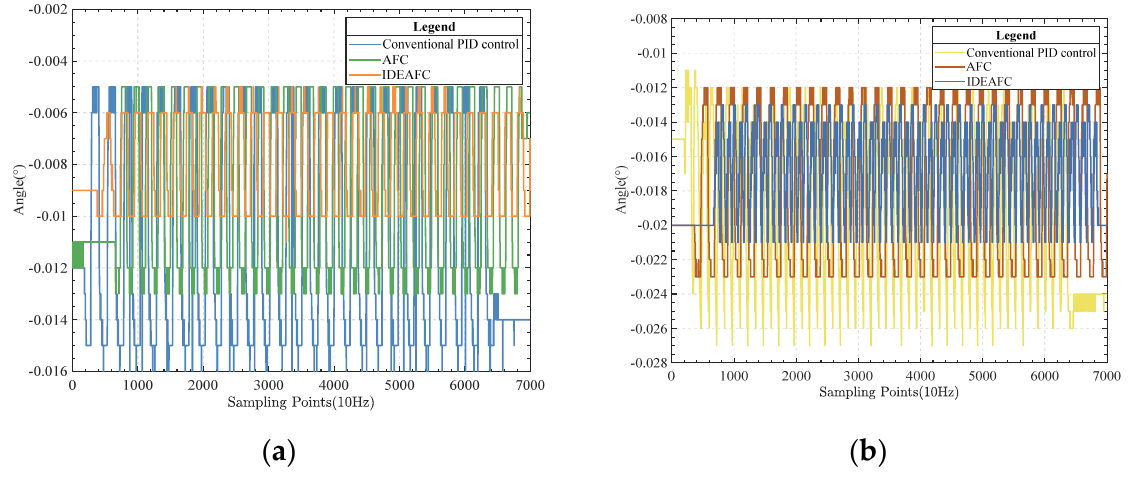
Figure 16. ( a ) Pitch angle data comparison; ( b ) roll angle data comparison. Using the comparison graphs, we can compare the control effects of the three control algorithms in the swing experiment, as shown in Table